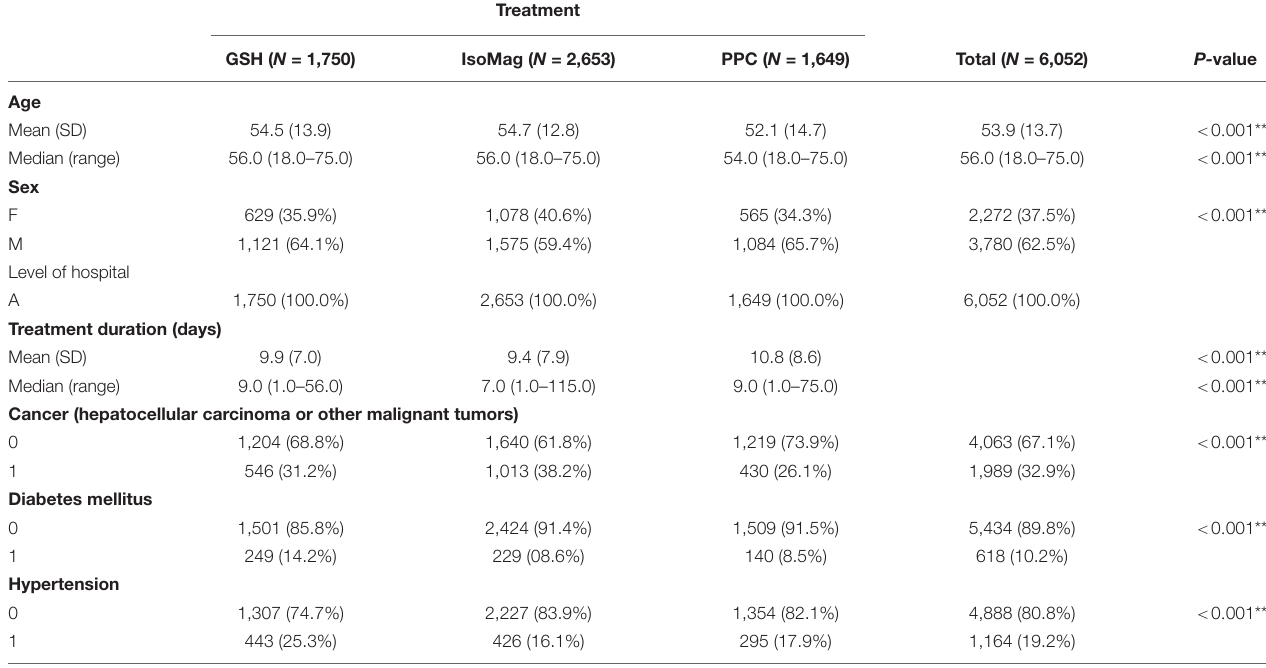
TABLE 2 | Patients characteristics by treatment groups.